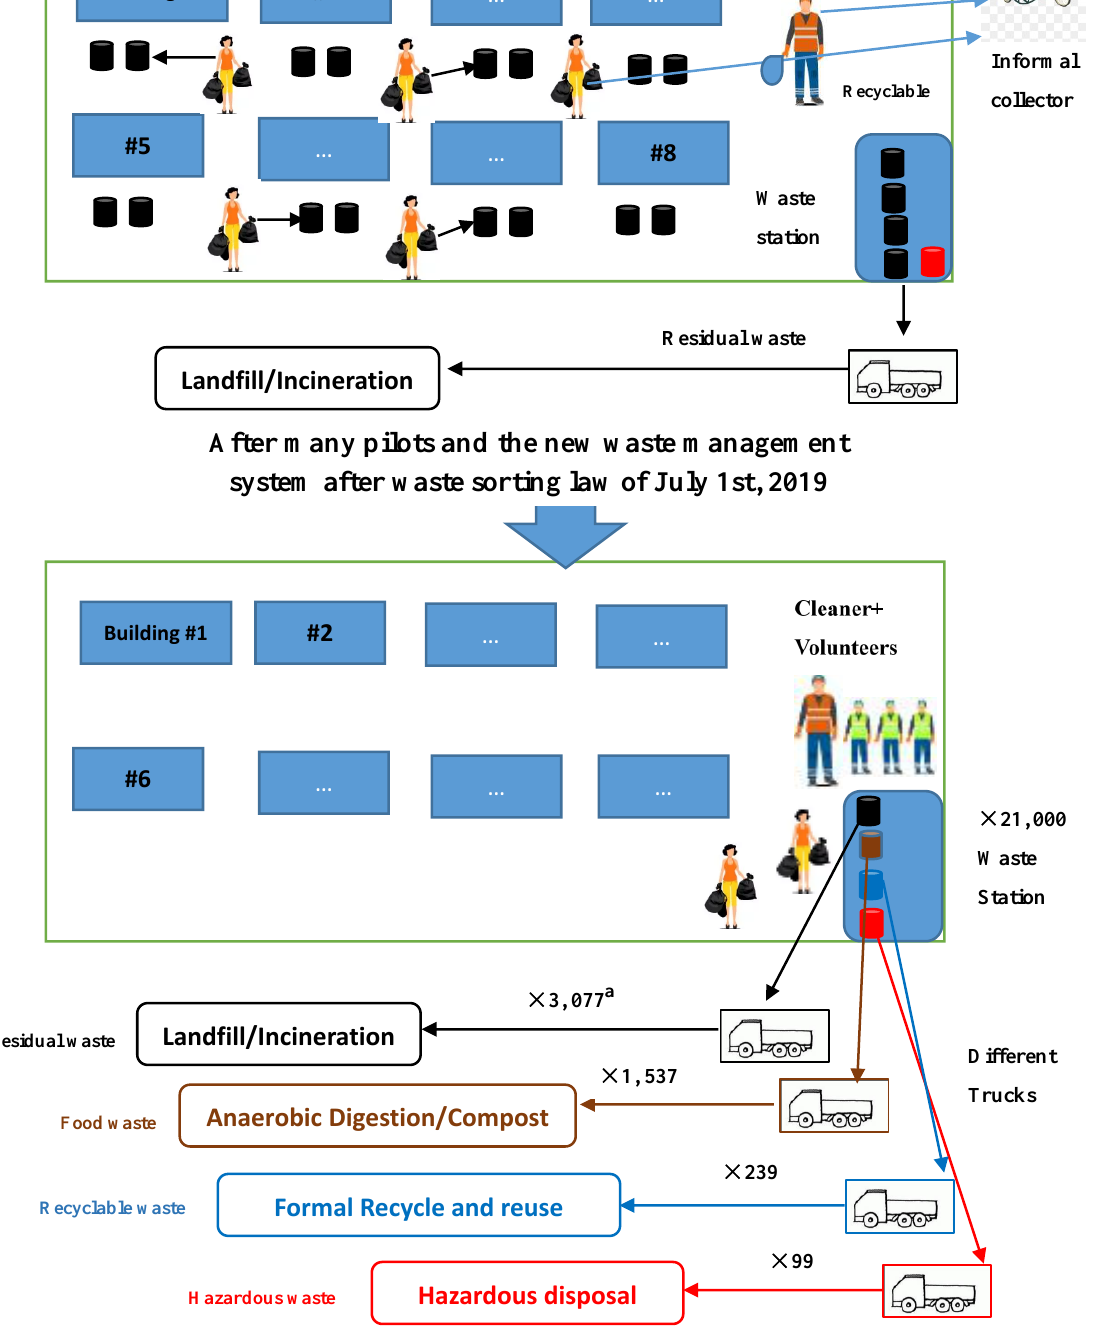
Figure 1. Changes to Shanghai’s overall waste management system, in the context of residential buildings within an enclosed community. The January 2019 policy pulled together different modifications into one interconnected policy, and legally enforced in the July 2019 policy. It was also the first time that enforceable regulations applied to resident responsibilities: city-wide publicity and training in local communities ensured this mandate was clear. a means there are 3077